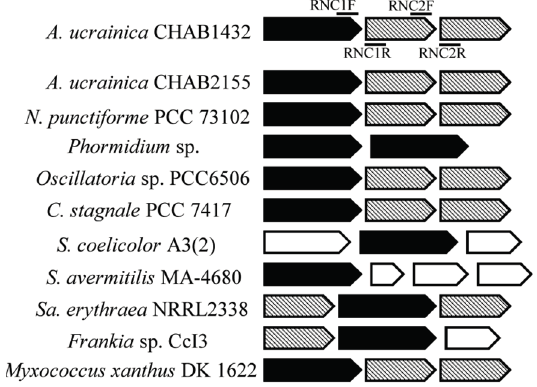
Figure 3. Organization of genes that encode predicted geosmin/germacradienol synthases and flanking genes in different microorganisms. The filled, oblique-lined and unfilled arrows indicate the geosmin/germacradienol synthase gene, cyclic nucleotide-binding protein gene ( cnb ) and other unrelated genes, respectively. Line segments located in A. ucrainica CHAB 1432 show the positions of primers RNC1F(R) and